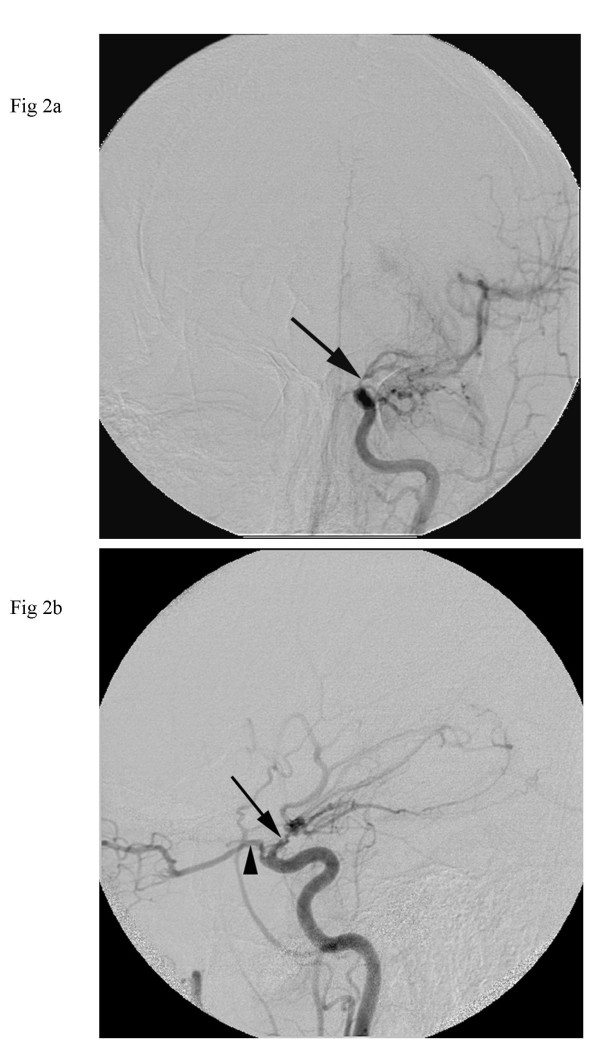
Anterior-posterior (a) and lateral (b) projections from a digital subtraction catheter arteriogram confirm the presence of a dissection (arrow) of the intracranial carotid, just beyond the ophthalmic artery origin (arrowhead).